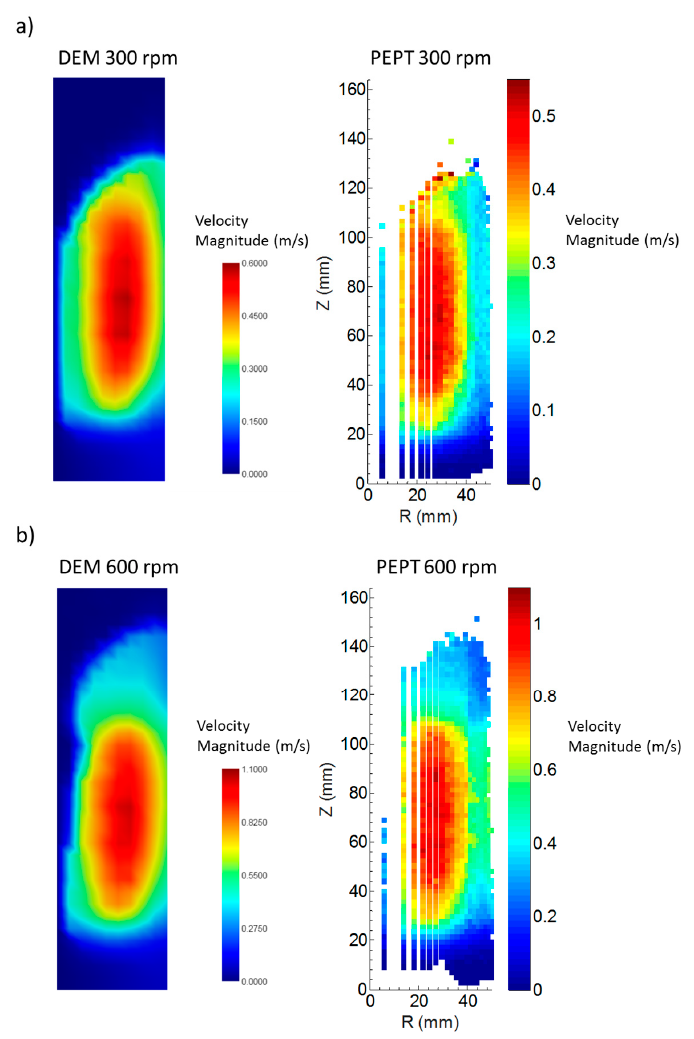
Figure 15. Comparison of the velocity flow field for DEM simulations and PEPT data at the impeller speed of ( a ) 300 rpm and ( b ) 600 rpm.